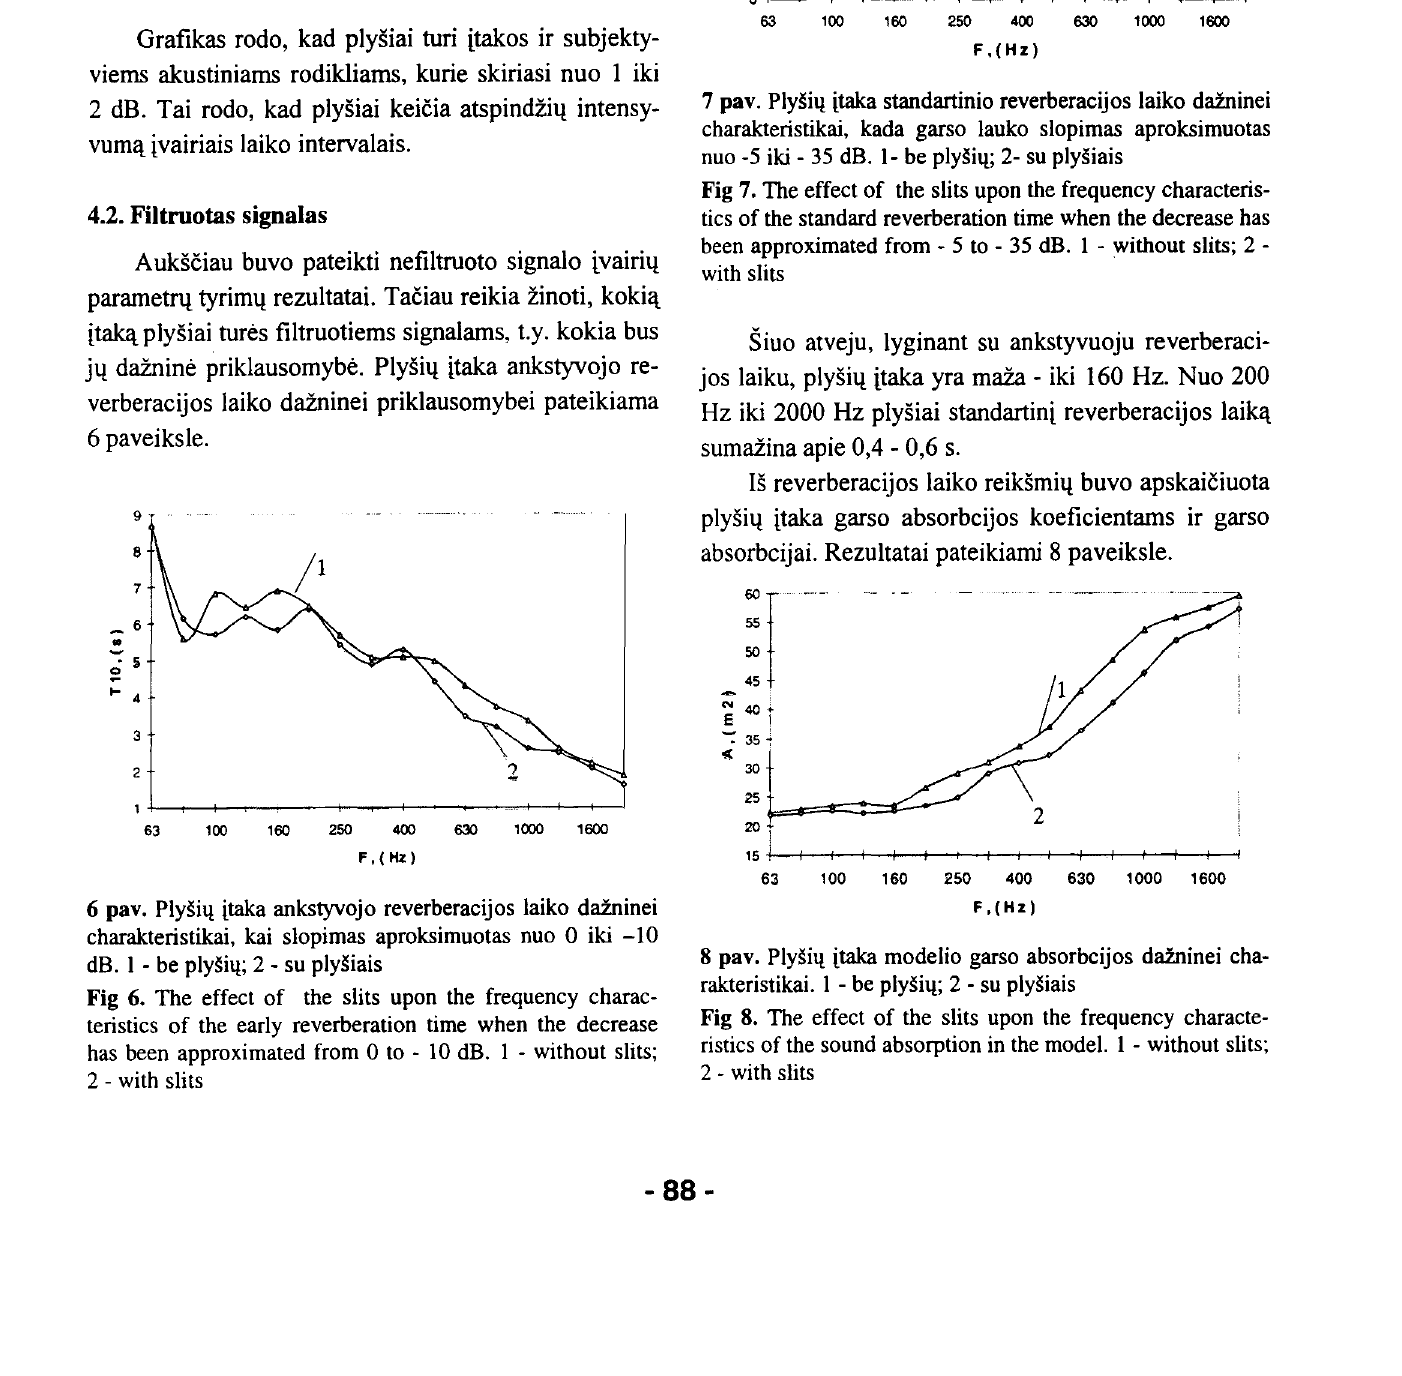
Fig 5. The dependence of subjective indicators of the model on slits. 1 - without slits; 2 - with slits Grafikas rodo, kad plysiai turi itakos ir subjekty vierns akustiniarns rodikliams, kurie skiriasi nuo 1 iki 2 dB. Tai rodo, kad plysiai keiCia atspindziq intensy vum&. ivairiais laiko intervalais.